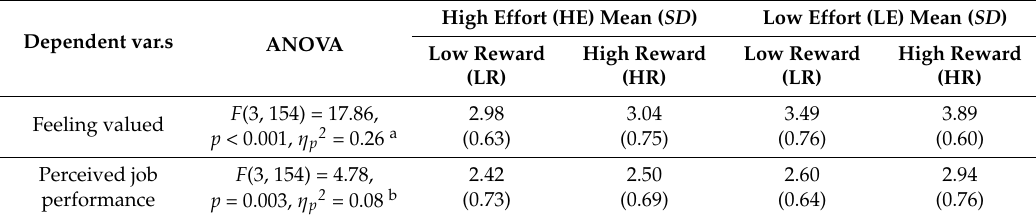
Table 3. Analysis of variance and descriptive